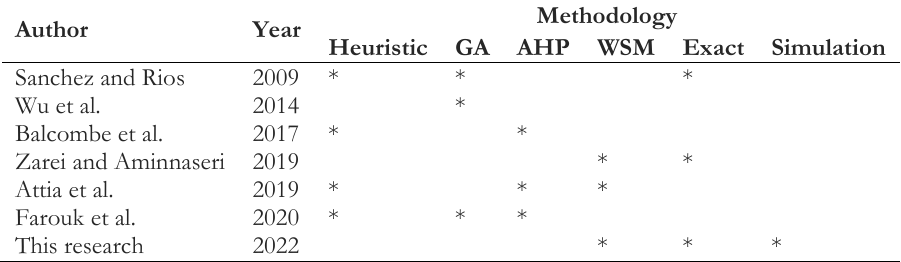
Table 1. Literature categorized.